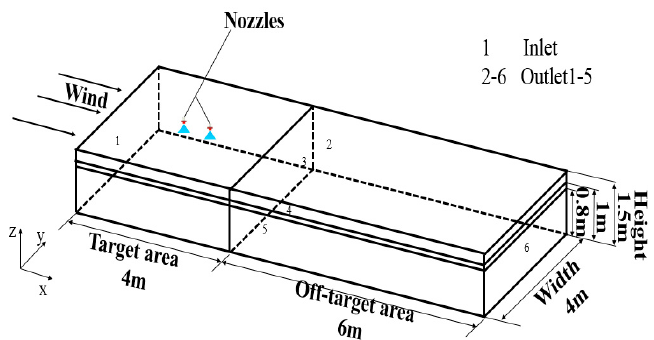
Figure 2. Computational domain and boundary setup are shown. The two nozzles are positioned on top of the domain.